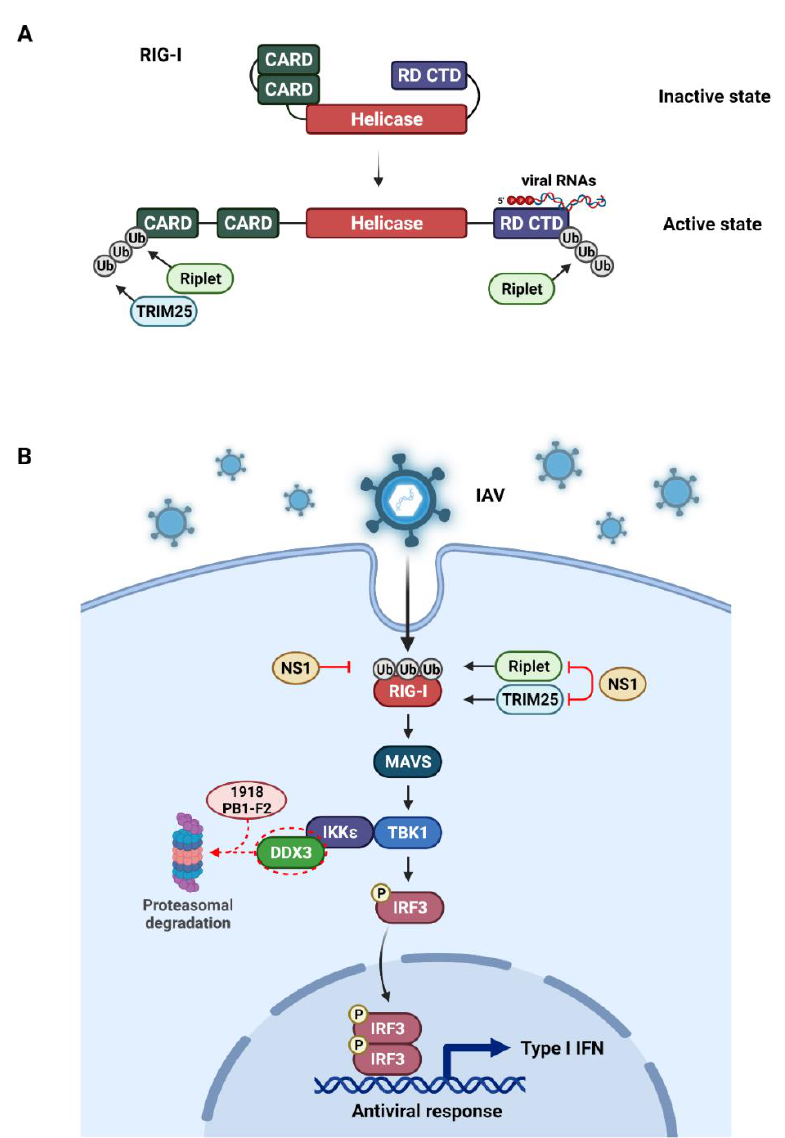
Figure 2. The influenza virus evasion mechanism through ubiquitin modulation of host cell proteins. The IAV recognition signaling pathway, triggered by the innate immune sensor RIG-I represented. ( A ). The RIG-I binds to the viral RNA (e.g., the 5 (cid:48) ppp RNA) and undergoes a conformational change that opens CARD domains. The CARD domain is then activated by ubiquitination, catalyzed by either TRIM25 or Riplet E3 ligases. ( B ). After viral RNA detection, RIG-I recruits MAVS to activate the TBK1- IKK (cid:15) complex, which is needed for the activation of IRF3. The IRF3 then translocates to the nucleus and induces type I IFNs. The IAV NS1 suppresses the TRIM25 or Riplet-mediated ubiquitination of RIG-I caspase. The NS1 RBD from 1918 H1N1 strain inhibits RIG-I ubiquitination. Highly pathogenic PB1-F2 protein from 1918 H1N1 strain also antagonizes IFN production by proteasomal-mediated degradation of DDX3. This illustration was created with